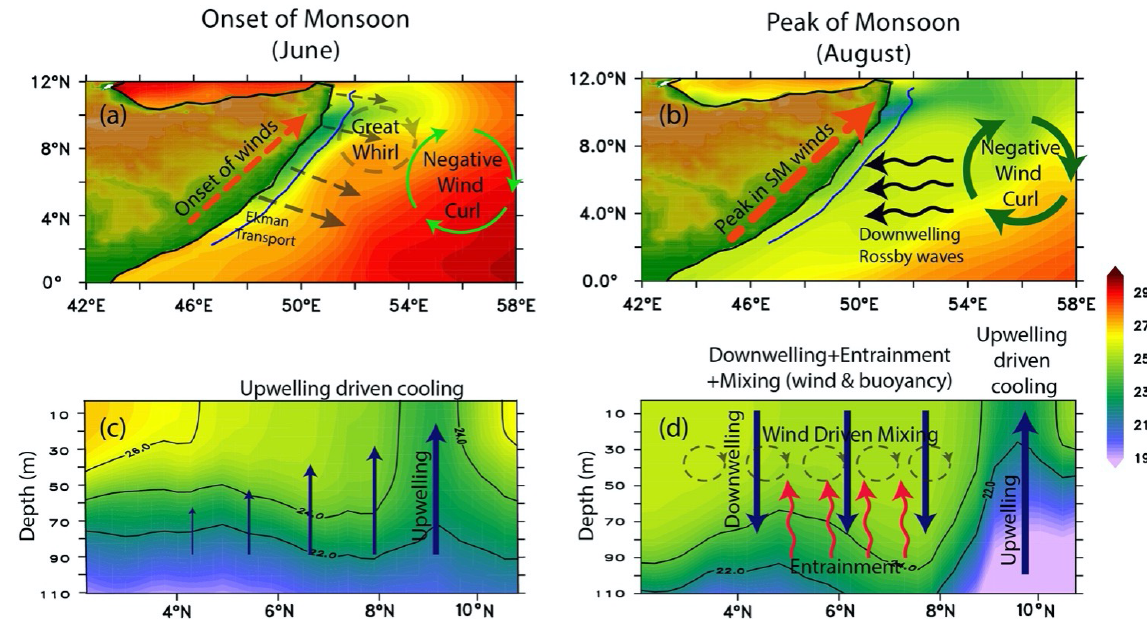
Figure 13. Climatological SST ( ◦ C; a, b ) and vertical section of temperature ( ◦ C; c, d ) along the vertical section aligned roughly around the 1000m isobath (blue contour along the Somali coast in the top panels) for the month of June (left panels) and August (right panels). The climatology is computed from model (Modular Ocean Model, Version 5.1) interannual simulations for 1993–2018 (reproduced from Chatterjee et al., 2019; Lakshmi et al., 2020). As the monsoon begins in early June, southwesterly winds blow along the coast of Somalia (dashed red arrow) leading to offshore coastal upwelling (upward blue arrows; c ) driven by Ekman transport (which is stronger in the south than the northern part; see dashed black arrows in panel a ). Though the offshore transport is strongest in the south, the maximum upwelling (upsloping of thermocline) is seen along the front of the Great Whirl north of ∼ 8 ◦ N (c) . Notably, offshore wind stress curl turns negative south of the Findlater Jet axis favourable for open-ocean downwelling. As the monsoon peaks, this negative wind stress curl radiates downwelling Rossby waves (b) which propagate westwards and upon reaching the Somali coast deepen the thermocline there against the upwelling-favourable winds (downward-pointing blue arrows; d ). Further, stronger winds during the peak monsoon enhance wind-driven mixing which further deepen the thermocline in most parts of the Somalia coast. By late summer, the upwelling remains confined to the front of the Great Whirl in the northern part of the Somalia